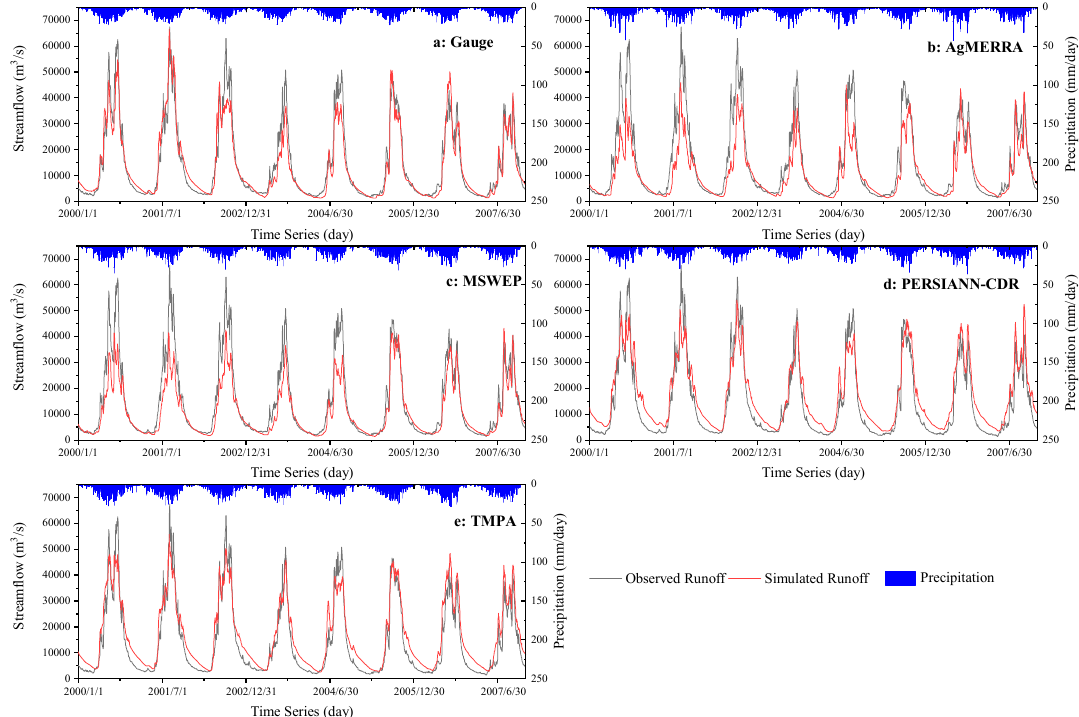
Figure 7. Comparison of SWAT-simulated streamflow with fixed parameters and observed streamflow in MRB in the calibration and validation periods (January 2000 to December 2007) at daily scale. (a: Gauge, b: AgMERRA, c: MSWEP, d: PERSIANN-CDR, and e: TMPA).